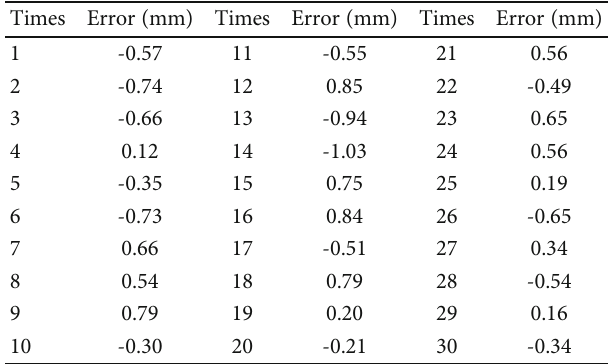
Table 4: Positioning error of hydraulic rod with 200 mm movement